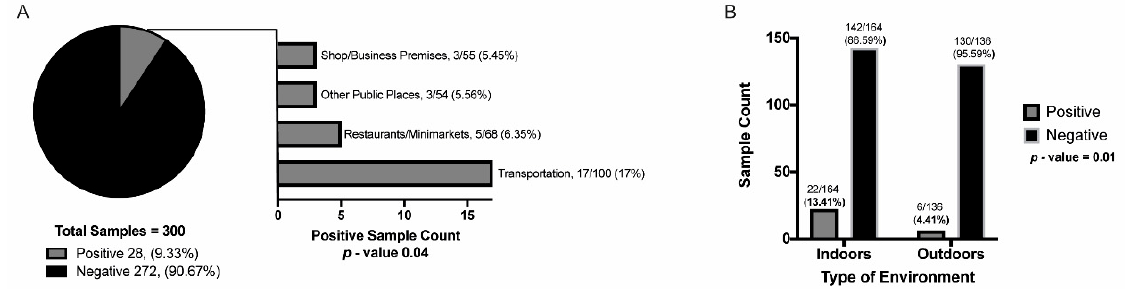
Figure 2. Percentage of positive and negative samples for SARS-CoV-2 viral RNA, and its distribution. ( A ) Percentage of positive samples found at the following different sampling sites: shop/business premises, other public places, restau- rants/minimarkets, transportation (parks category not included as there were no positive samples found), and ( B ) percent- age of positive and negative samples by type of environment (indoor/outdoor). The p -values obtained from the bivariate analyses are displayed.